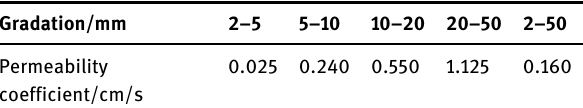
Table 3: Test results for the permeability coefficient of the model before grouting